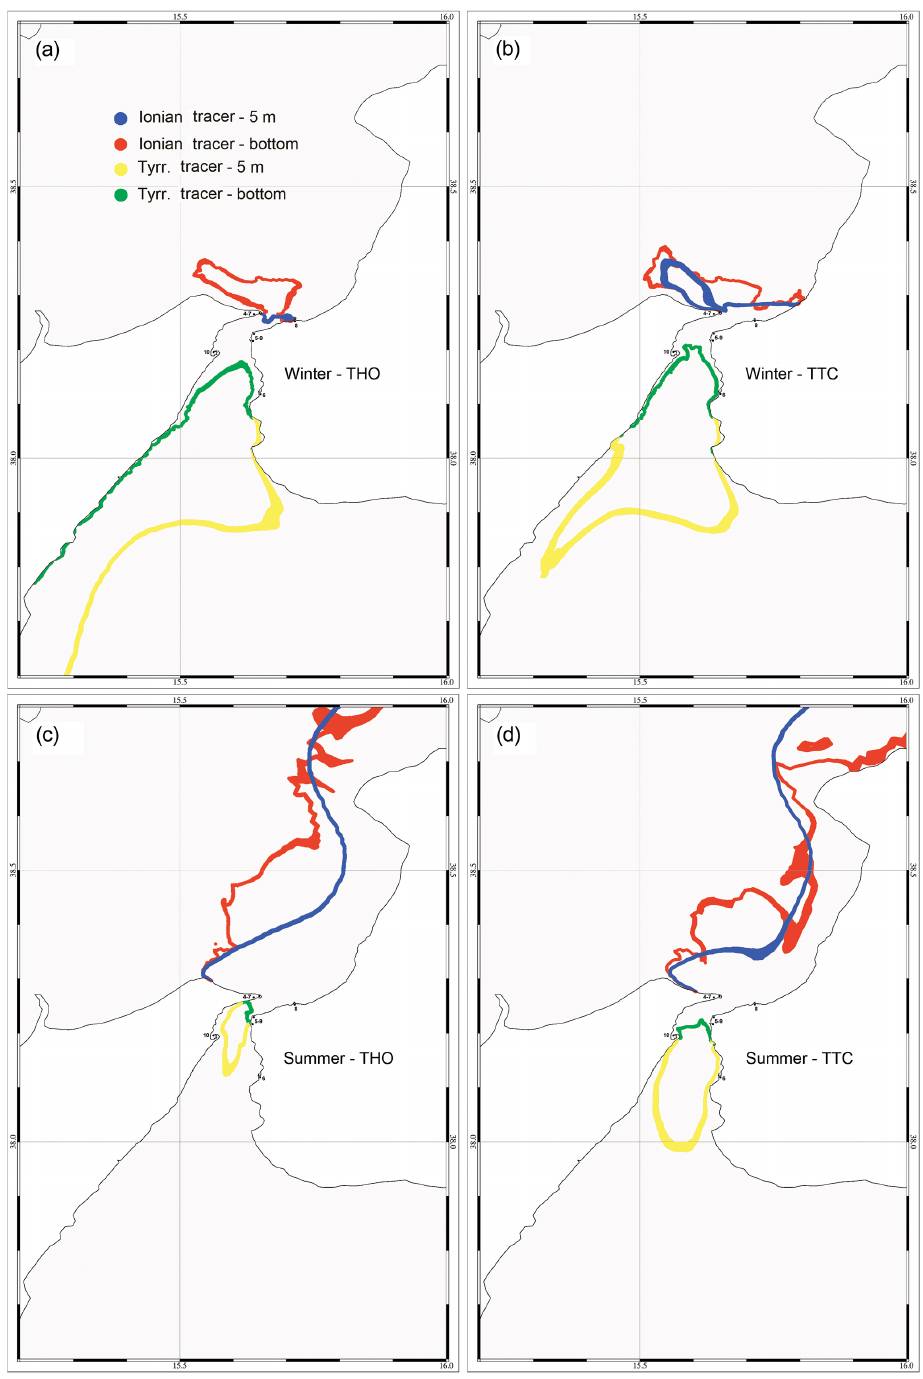
Figure 10. Monthly average distribution of tracers release during winter (upper panels) and summer (lower panels) from THO (left panels) and TTC scenario results (right panels). Coloured areas refer to values with 10% the initial tracer concentration. Red and blue lines refer to Ionian tracked waters at bottom and surface layers. Green and yellow lines refer to Tyrrhenian tracked bottom and surface layers water.